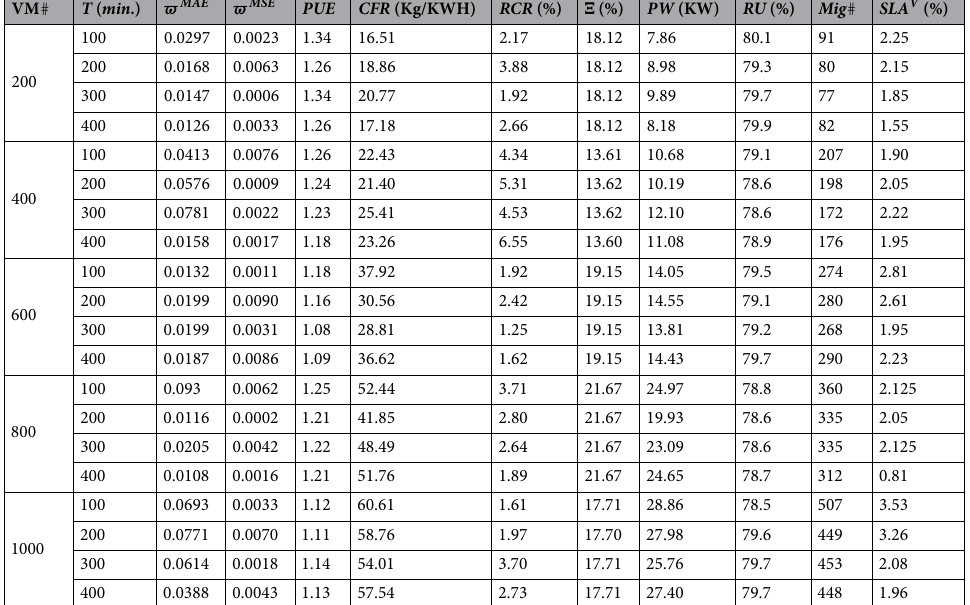
MAE MSE : MAE average, ̟ : MSE average, PUE : power V : SLA